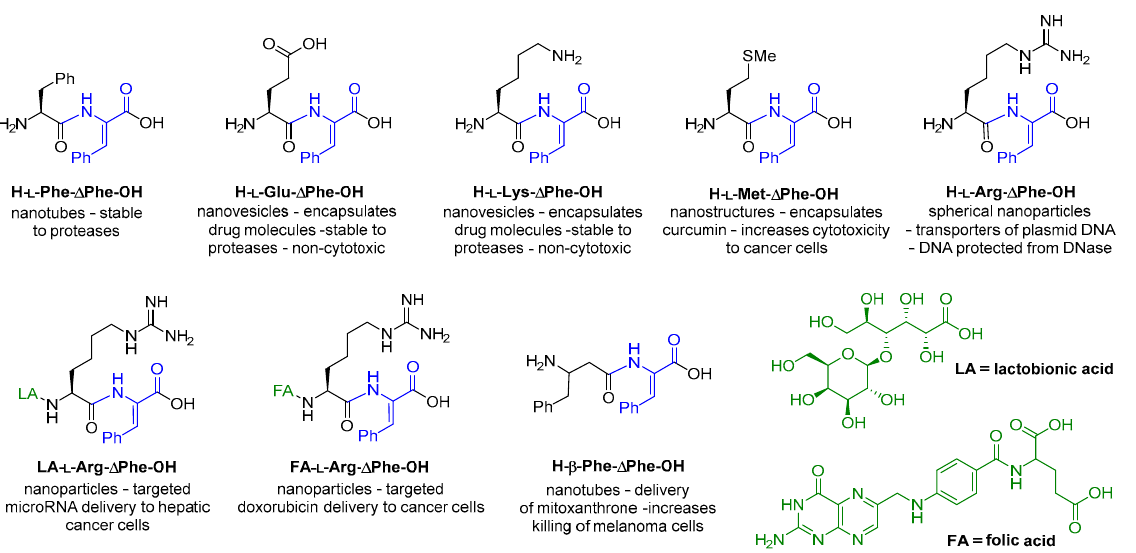
Figure 3. Summary of uncapped dehydrodipeptides capable of forming nanostructures.